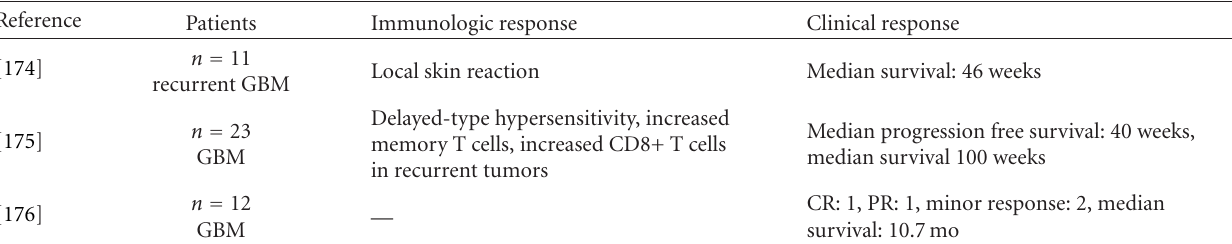
Table 5: Selected clinical trials using autologous tumor cells (ATCs).